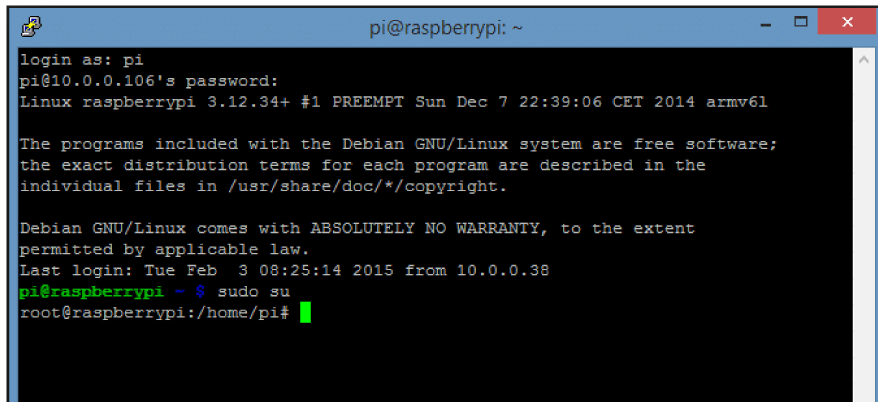
Figure 10. Logging into the software system through a command